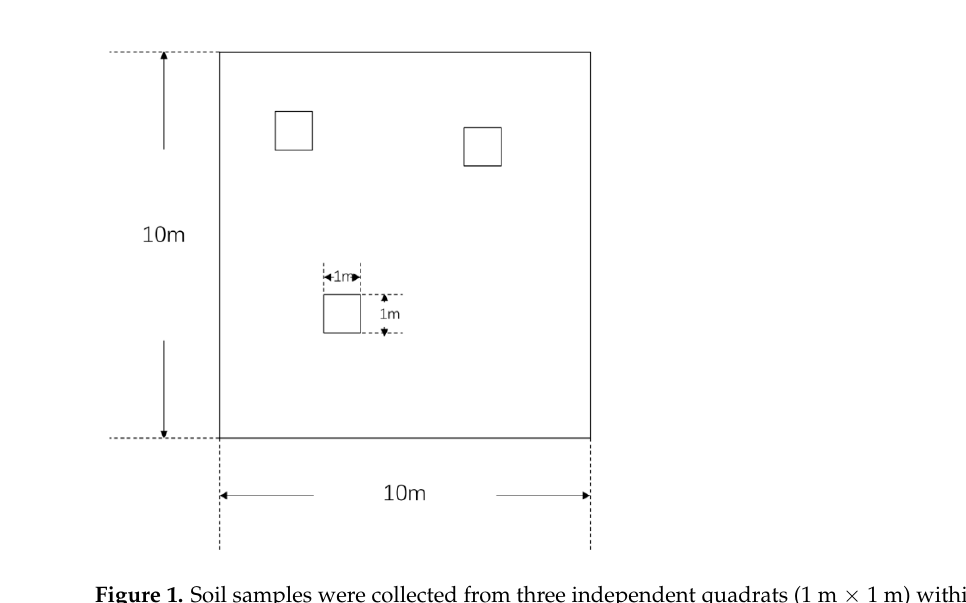
Figure 1. Soil samples were collected from three independent quadrats (1 m × 1 m) within each plot (10 m × 10 m).